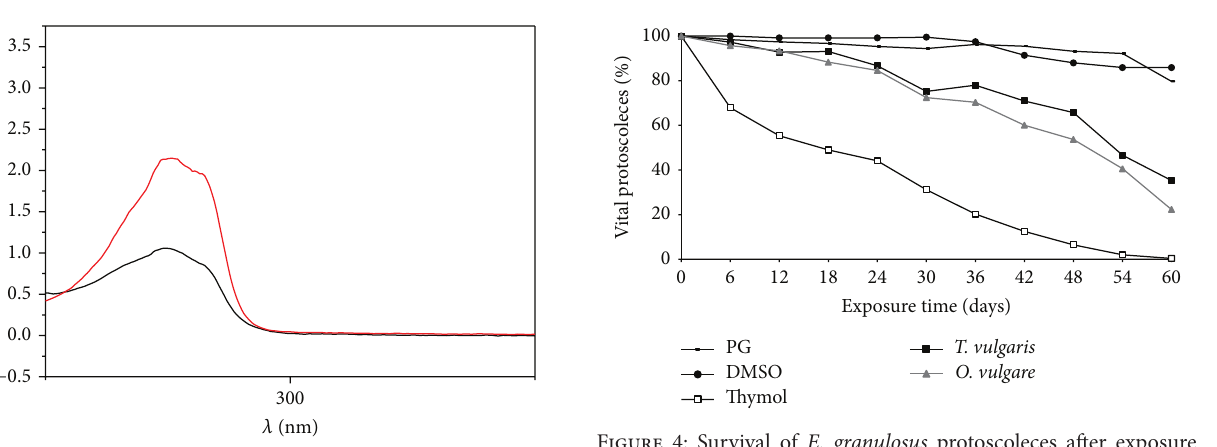
Figure 4: Survival of E. granulosus protoscoleces after exposure to thymol and essential oils of T. vulgaris and O. vulgare . Each point represents the mean percentage of vital protoscoleces from five different experiments. (PG: propylene glycol, DMSO: dimethyl